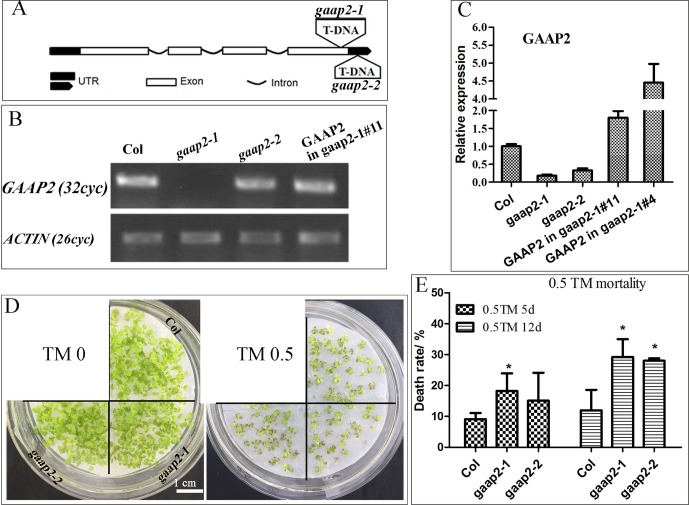

GAAP2 mutation increased the sensitivity of seedlings to TM treatment. (A) The schematic of T-DNA insertion sites in gaap2-1 and gaap2-2. (B–C) The expression of GAAP2 in 7-day-old seedlings of Col, gaap2-1, gaap2-2, and two transgenic lines with GAAP2 in gaap2-1was assayed by RT-PCR (B) and qRT-PCR (C). (D–E) GAAP2 mutation enhanced TM-induced plant death. Col, gaap2-1 and gaap2-2 seedlings were grown on 1/2 MS medium for 3 days and then transferred to 1/2 MS medium supplied with 0 or 0.50 μg ml−1 TM for another 12 days (D). The death rates of seedlings treated with 0.5 μg ml−1 TM for 5 and 12 days (E). Error bars depict a standard error of approximately three to four independent experiments. Significant differences compared with Col plants, as indicated by asterisks (χ2 test, *p < 0.05, n > 80).